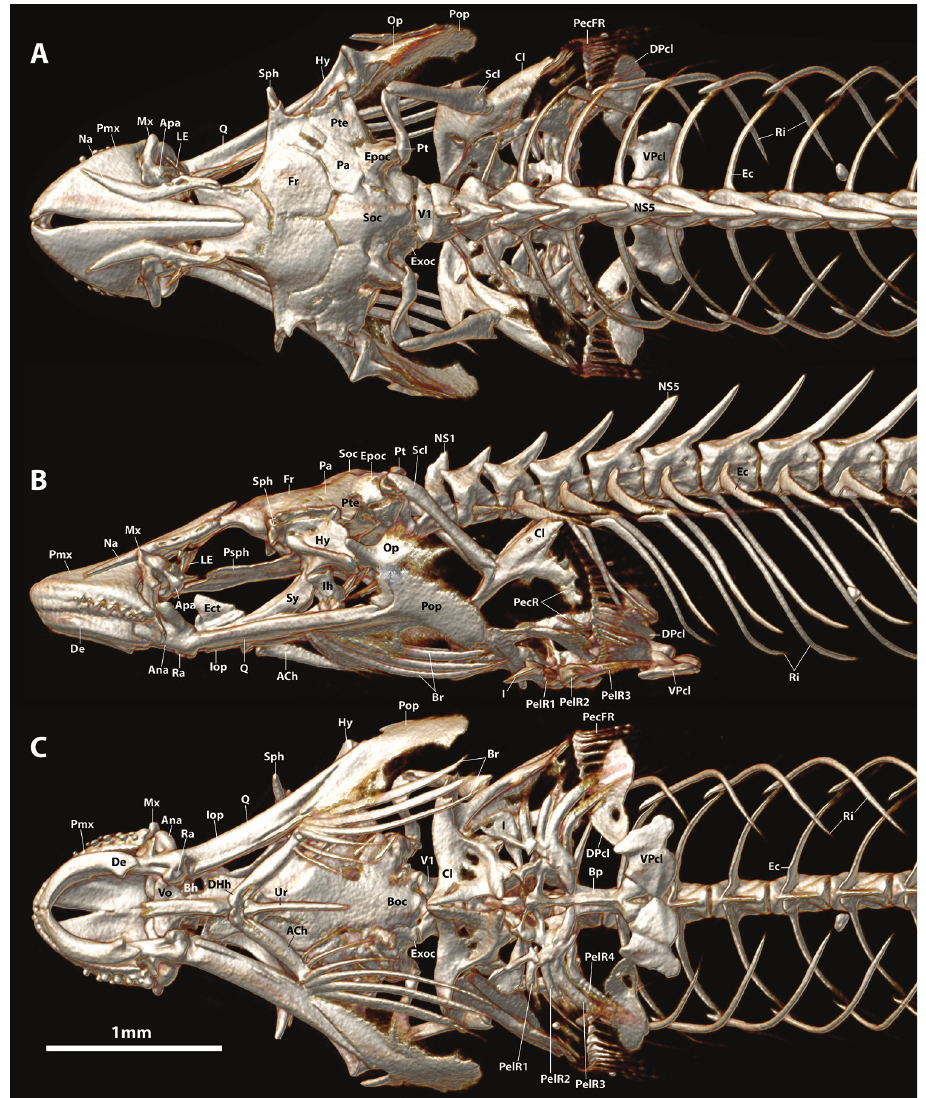
Figure 15. CT scanned anterior skeleton of Pherallodus indicus , NSMT-P 114703, 25.0 mm SL. A Dorsal view B Lateral view (left side) C Ventral view. Abbreviations: ACh, anterior ceratohyal; Ana, anguloarticular; Apa, autopalatine; Boc, basioccipital; Bp, basipterygium; Br, branchiostegal rays; Cl, cleithrum; DHh, dorsal hypohyal; DPcl, dorsal postcleithrum; Ec, epicentral; Ect, ectopterygoid; Epoc, epiotic; Exoc, exoccipital; Fr, frontal; Hy, hyomandibular; I, pelvic-fin spine; Iop, interopercle; LE, lat- eral ethmoid; Na, nasal; NS1, 5, neural spine of vertebral centrum 1, 5; Op, opercle; Pa, parietal; PecR, pectoral radial; PecFR, pectoral-fin ray; PelFR1-4, pelvic-fin ray 1–4; Pop, preopercle; Pro, prootic; Psph, parasphenoid; Pt, posttemporal; Pte, pterotic; Q, quadrate; Ra, retroarticular; Ri, rib; Scl, supra- cleithrum; Soc, supraoccipital; Sph, sphenotic; Ur, urohyal; V1, vertebral centrum 1; Vo, vomer; VPcl, ventral